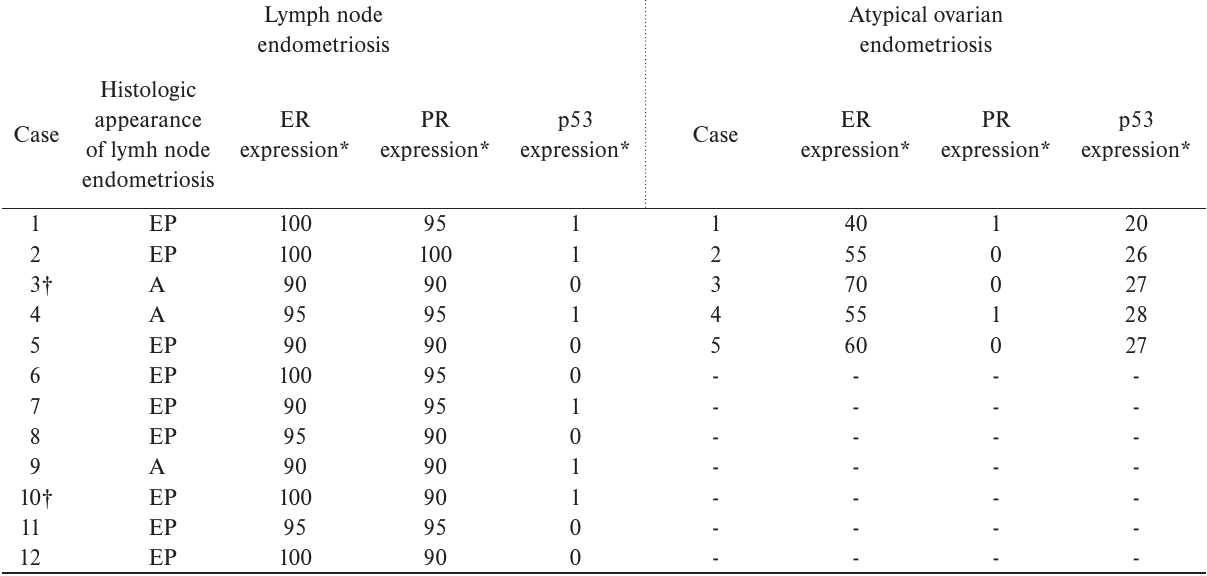
Table 2. Pathologic features of lymph node endometriosis and immunohistochemical analysis of oestrogen and progesterone receptor and p53 expression in lymph node endometriosis (group 1) and atypical ovarian